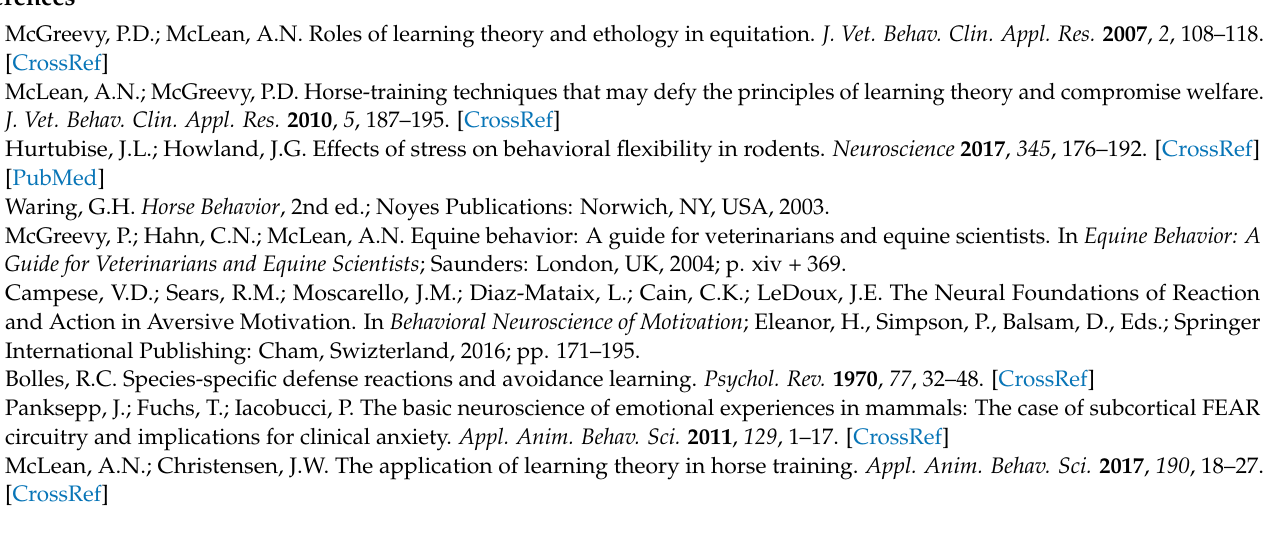
Figure S6: Mean predicted probability a > 1 step response occurring in the OL1 session compared to the response shift session; Figure S7: Mean taps/trial comparing the first original learning session to the cognitive flexibility session session; Figure S8: Mean BDNF concentrations (pg/mL) between the first original learning session and the cognitive flexibility